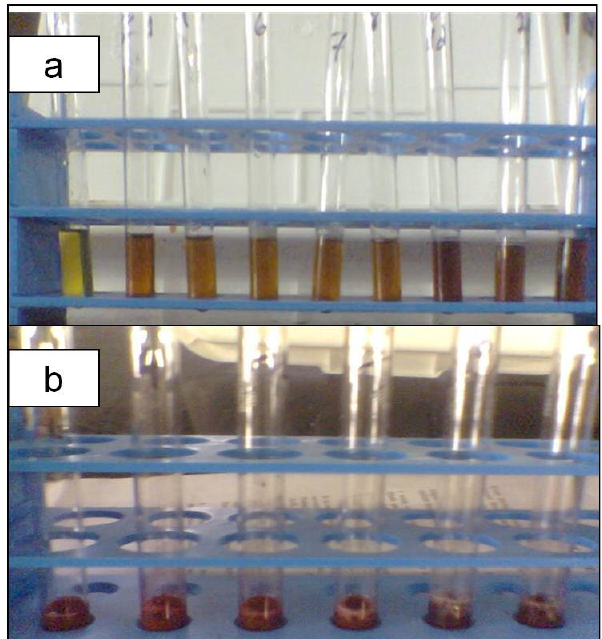
Figure 2. Colour change by the siderophore producing isolates in FeCl 3 and tetrazolium